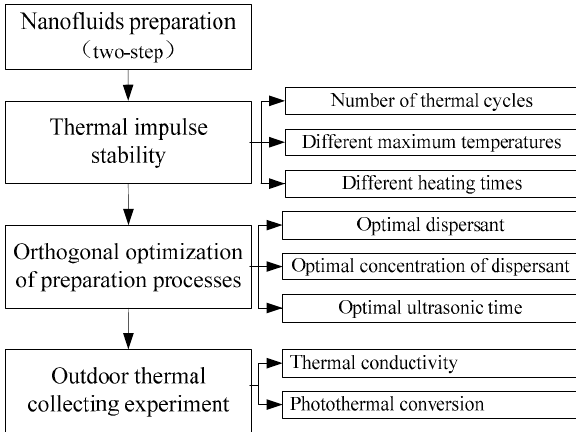
Figure 1. Research approach (flowchart).